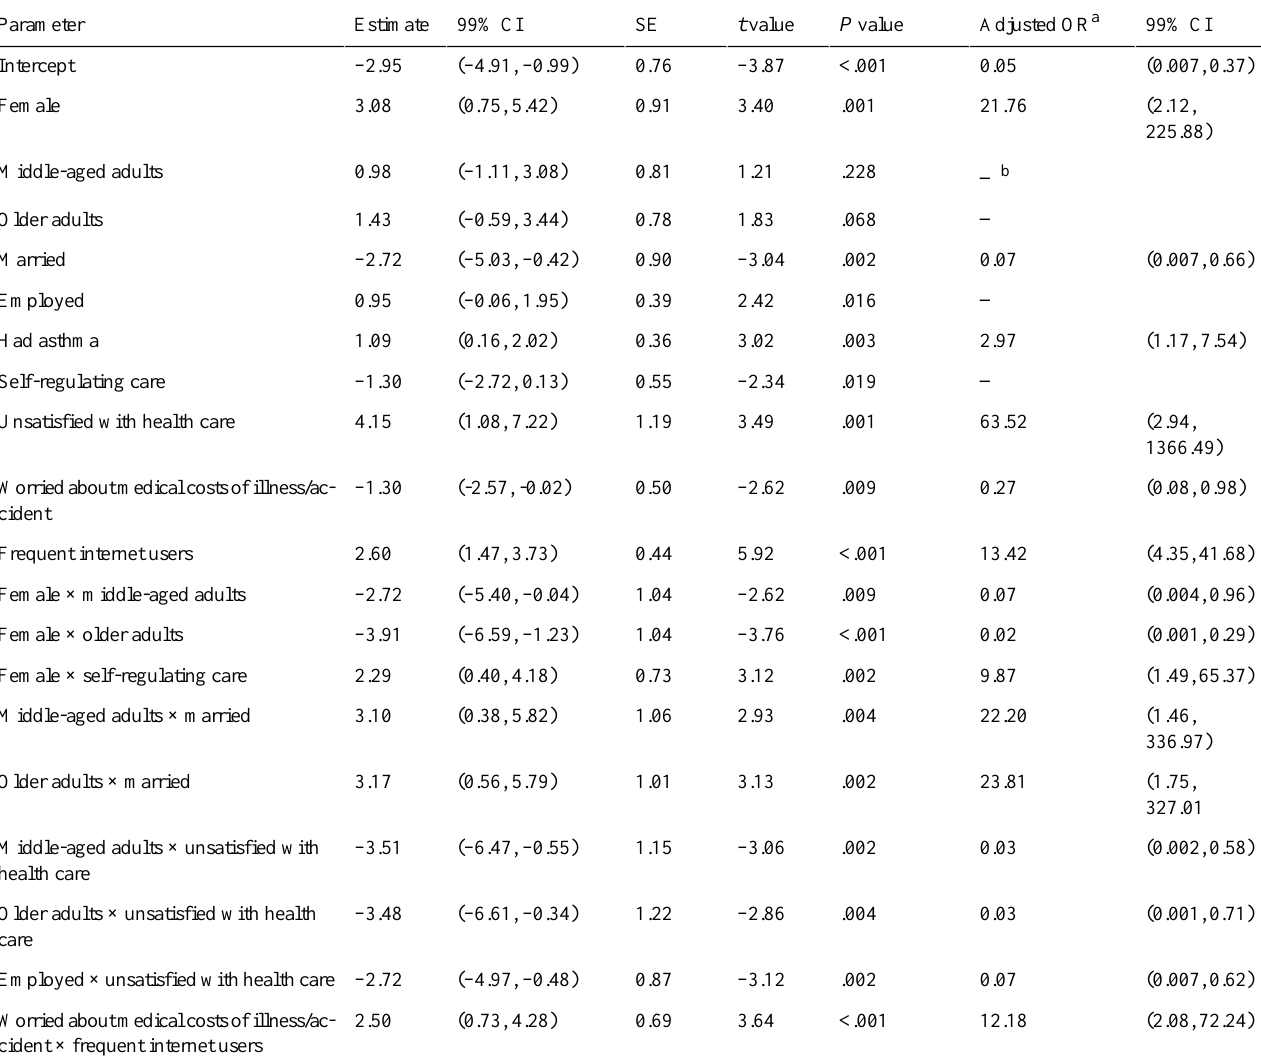
Table 2. Binary logit model for the likelihood of looking up health information on